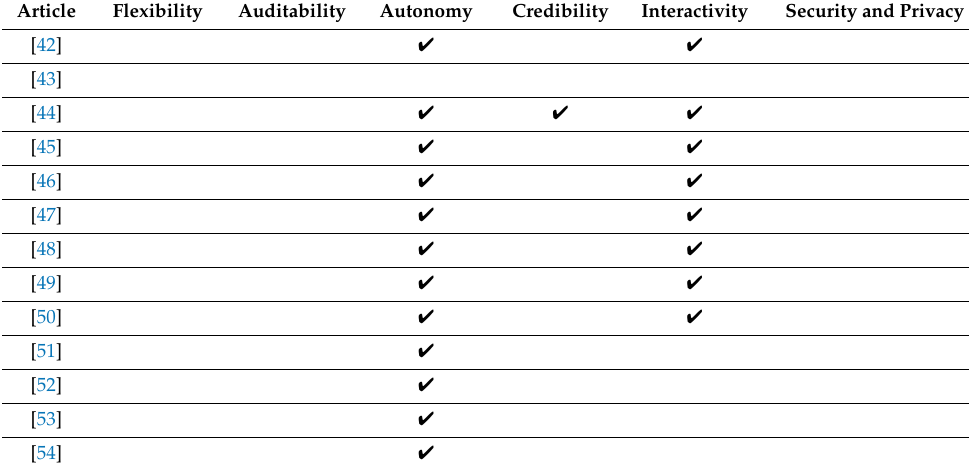
Table 6. Rehabilitation articles.